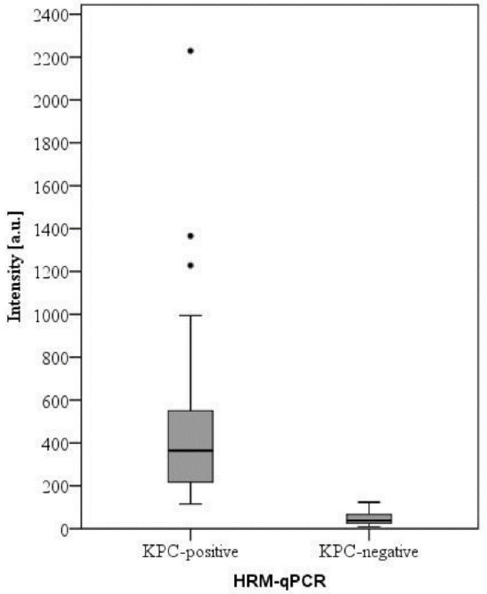
Figure 1. False negative (7595F, 8219F, and 8649F) and false positive (8238F and 8396F) results, considering the visual analysis of the spectra (positive control: 7606F) and the intensities of the peak with the expected m / z for KPC, compared with HRM-qPCR. I: intensity; a.u.: arbitrary units; MIC: meropenem minimal inhibitory concentration.